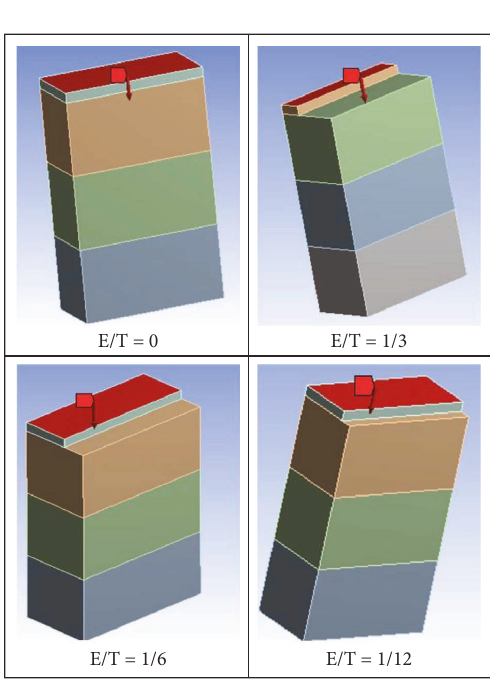
Figure 3: CSRE specimens with H/T � 3 models at different